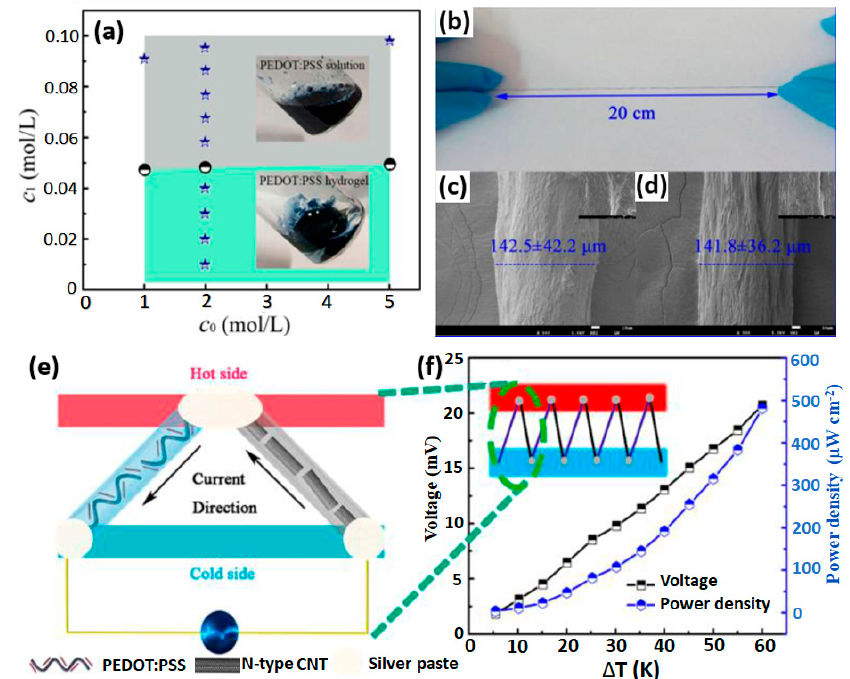
Figure 4. (a) The effect of the H 2 SO 4 concentration on the gelation process of PEDOT:PSS. Shaded regions present that PEDOT:PSS is able (green) and unable (gray) to gel with various H 2 SO 4 contents. ( b ) Digital photographs of as-fabricated PEDOT:PSS fiber. SEM images of PEDOT:PSS fibers ( c ) before and ( d ) after ethylene glycol post-treatment. ( e ) Schematic diagram for thermoelectric device and ( f ) the output voltage and power density of five couples of legs at various temperature differences ranging from 5 to 60 K. Readapted with permission from American Chemical Society [42].